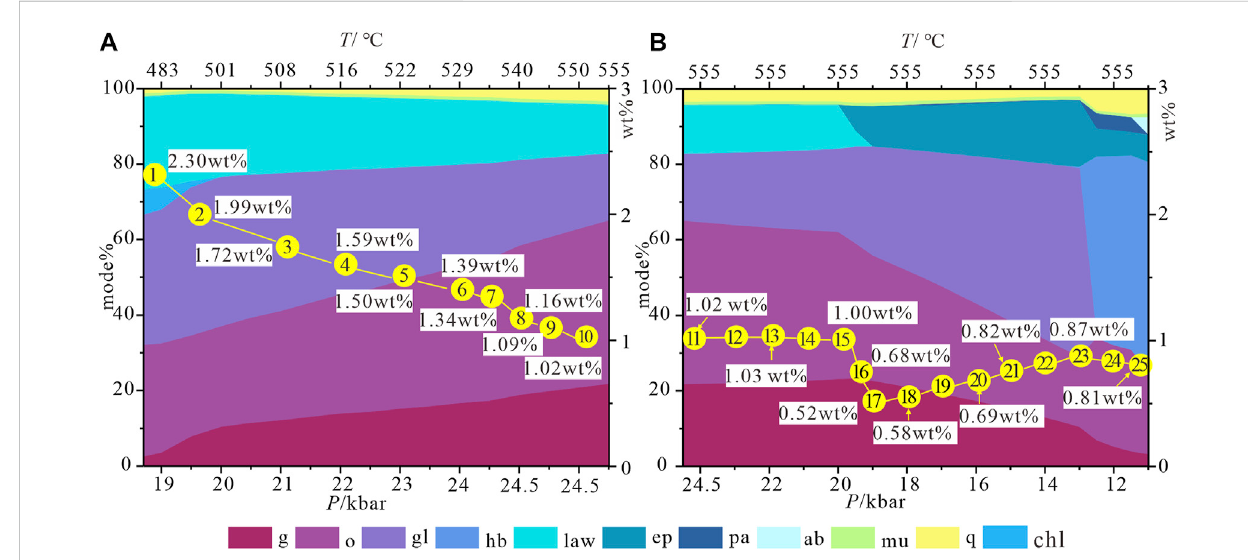
FIGURE 8 Modal variations for different phases (mode%) and corresponding H 2 O content (wt%) saturated for relevant assemblages from g + o + gl + chl + law + q + mu (A) to g + o + ep + hb + pa + pl + q + mu (B) along the inferred P – T path in Figure